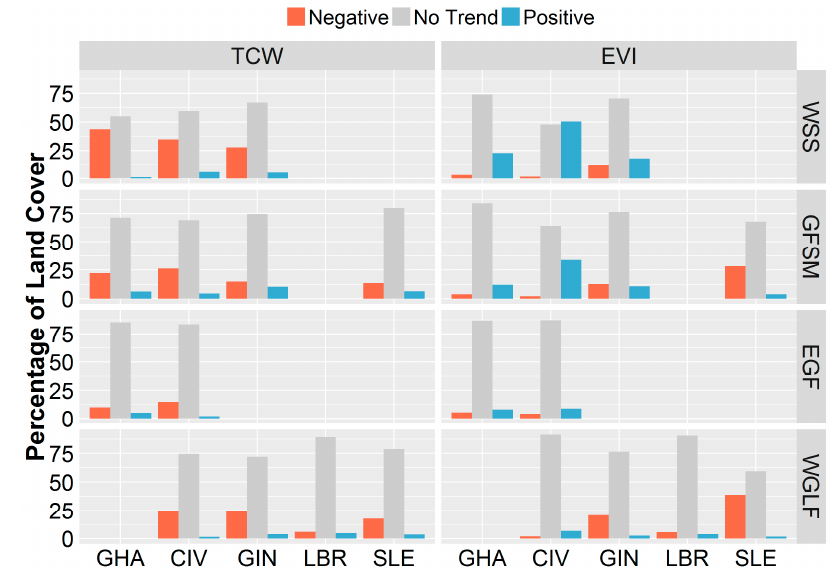
Figure 6. Summary of trend analysis results within different countries, stratified by WWF ecoregions. Abbreviations are: CIV: Côte d’Ivoire; GHA: Ghana; GIN: Guinea; LBR: Liberia; SLE: Sierra Leone; WSS: West Sudanian Savanna; GFSM: Guinean Forest-Savanna Mosaic; EGF: Eastern Guinean Forest; WGLF: Western Guinean Lowland Forests.